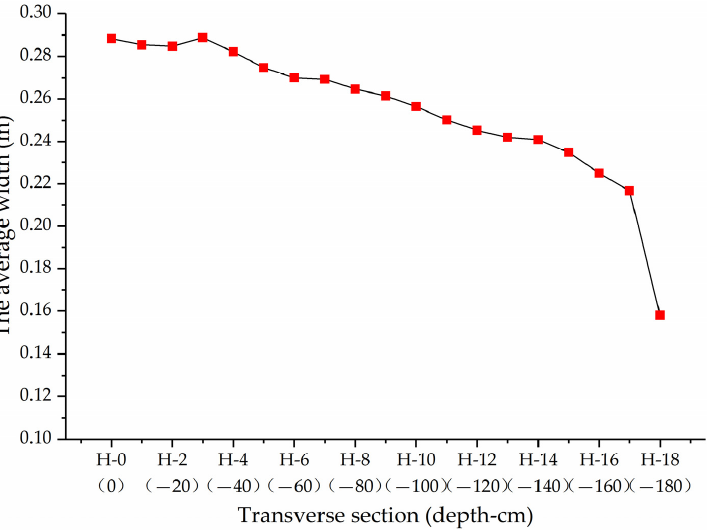
Figure 18. The variation of the average width of the ground fissure in each transverse section with depth. with